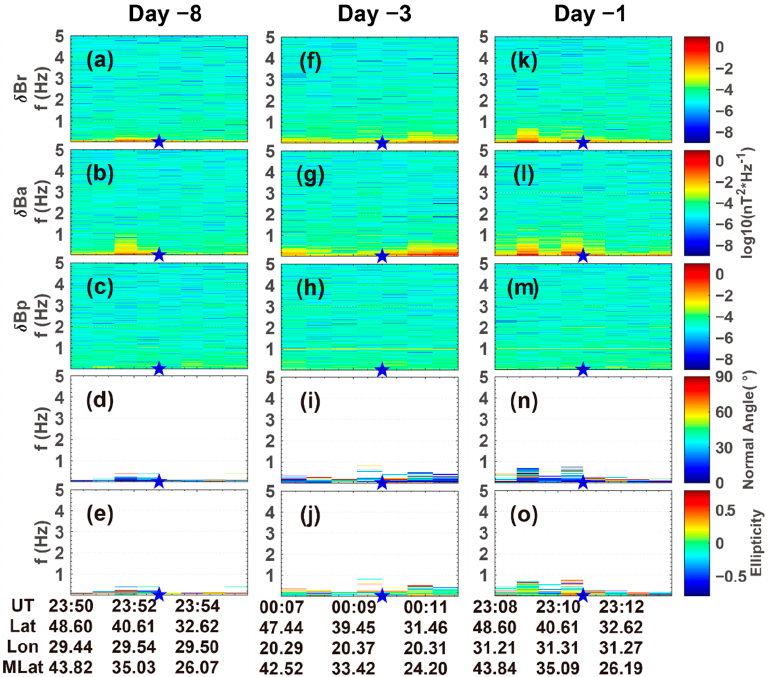
Figure A4. Power spectral density and polarization parameters of disturbed orbits at Δ T = − 8, − 3 and − 1 days. For example, ( a – c ) show the power spectral density of Br, Ba and Bp components at Δ T = − 8 days; ( d , e ) present wave normal angle and ellipticity at Δ T = − 8 days. The second and third columns ( f – o ) display results at Δ T = − 3 and − 1 days. The blue star indicates the epicenter.